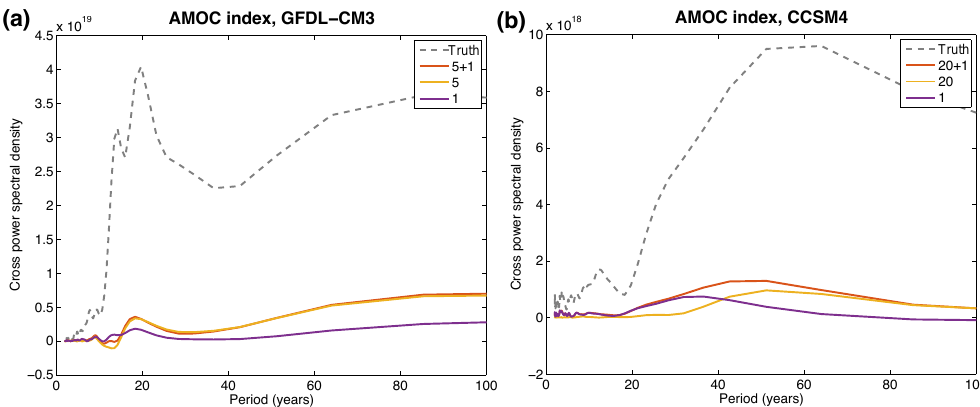
Figure 9. Cross spectra of the reconstructed AMOC index time series with the true AMOC index time series, for the reconstructions shown in Fig. 8. For reference, the dashed gray line indicates the cross spectra of the true time series with itself, or equivalently its own power spectrum.